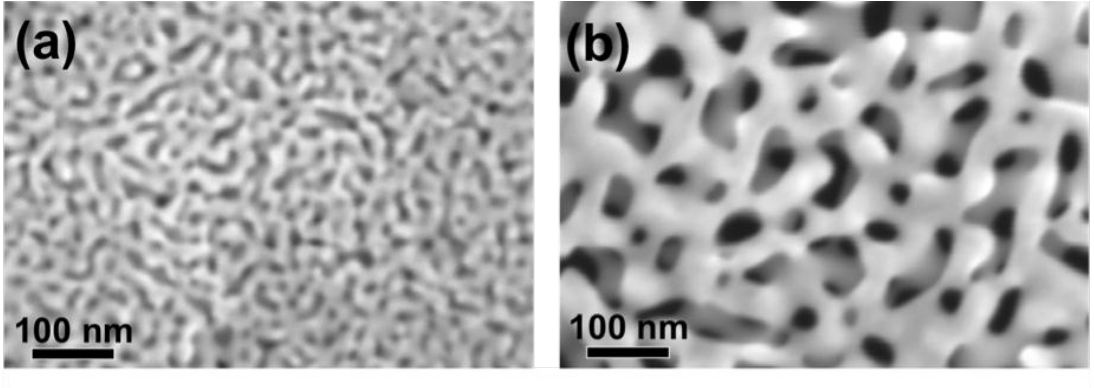
Figure 1: SEM images of NPG films. Pore diameter is (a) 20 nm and (b) 42